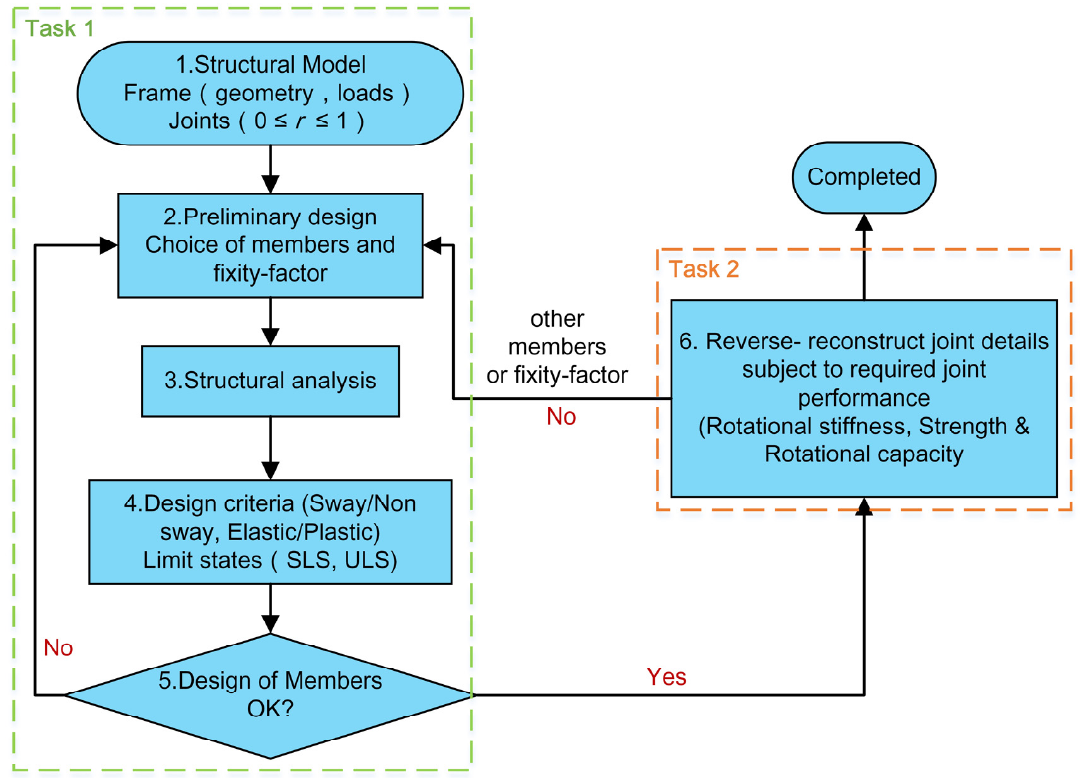
Figure 2. Proposed design process for semi-rigid steel frames.